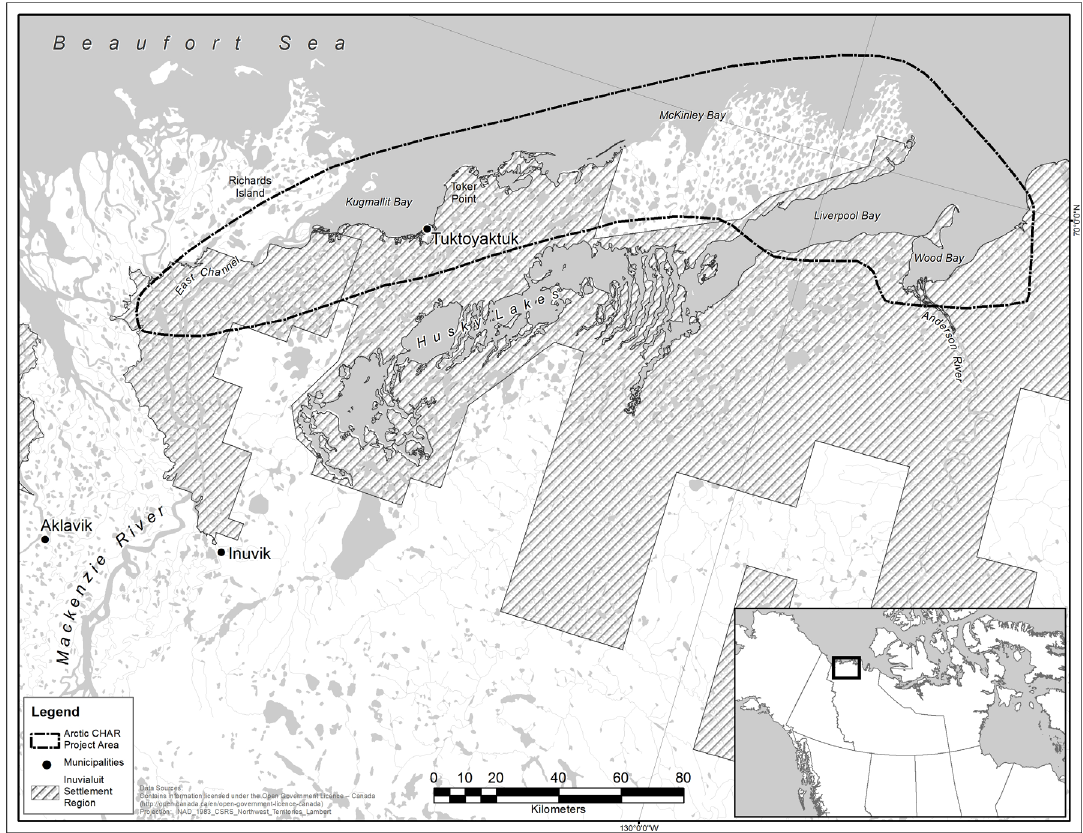
Fig. 1: Arctic CHAR Project study